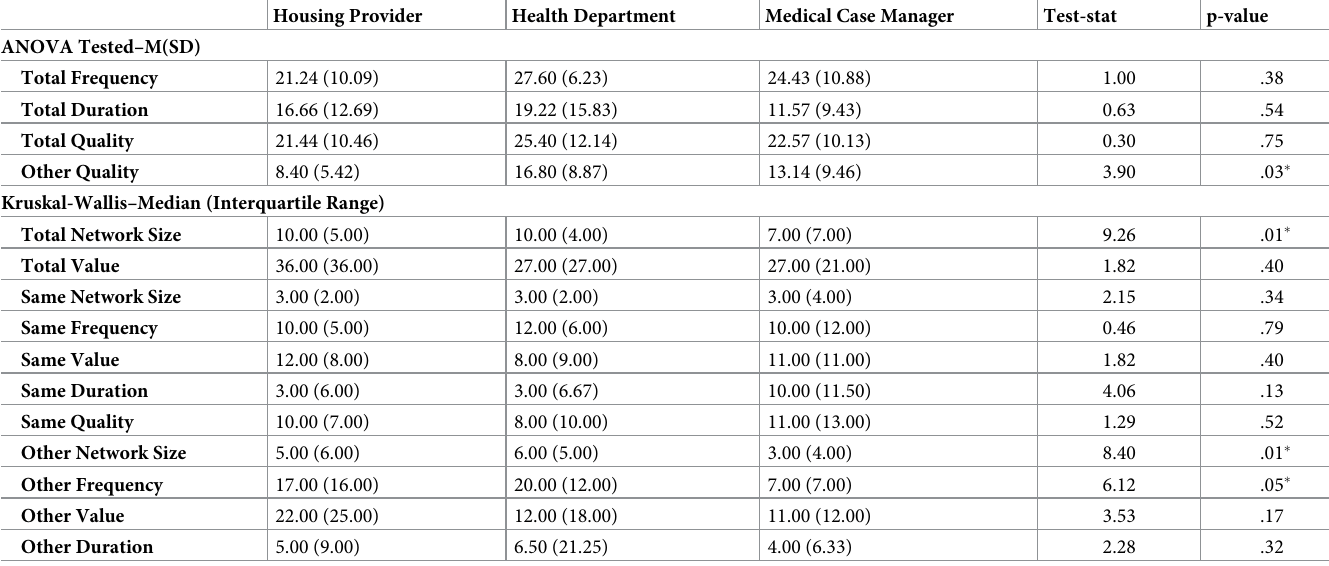
Table 2. Network composition score descriptive statistics, Kruskal-Wallis, and ANOVA